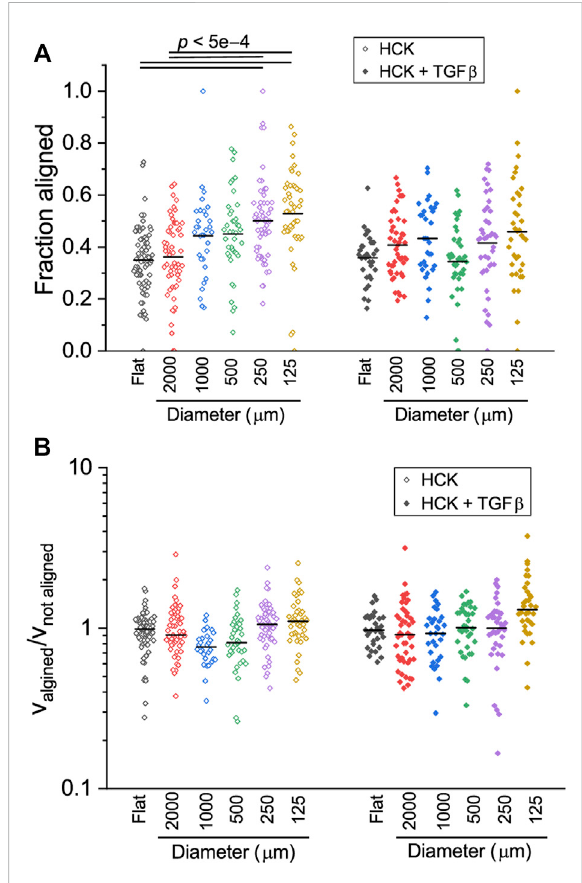
FIGURE 7 Direction-dependentmigrationofHCKandHCK+TGF β cells onconcavecylinders. (A) Fractionoftimethatcellsmigratedalong the longitudinal axis of the cylinder. HCK cells appear to spend moretimeonalignedmigrationwithincreasingcurvature. (B) Ratio of cell speed when aligned or non-aligned, indicating the no differences in speed for HCK and HCK + TGF β cells on all concave cylinders. Each data point represent one tracked cell ( n > 30 for each condition). Statistically signi fi cant differences are indicated with the p values; all other paired comparisons did not show statistically signi fi cant